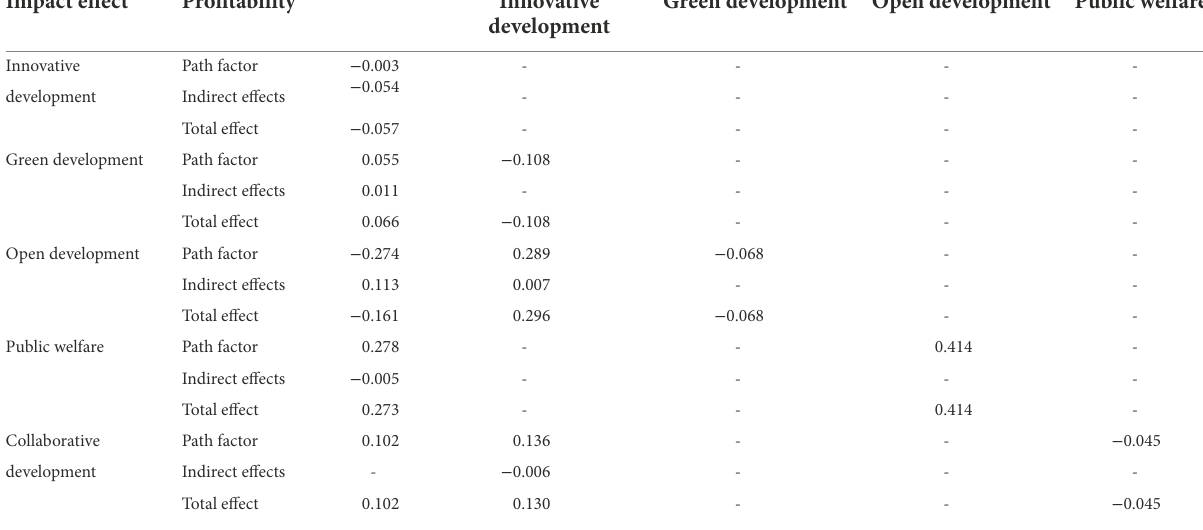
TABLE 6 Effects among the